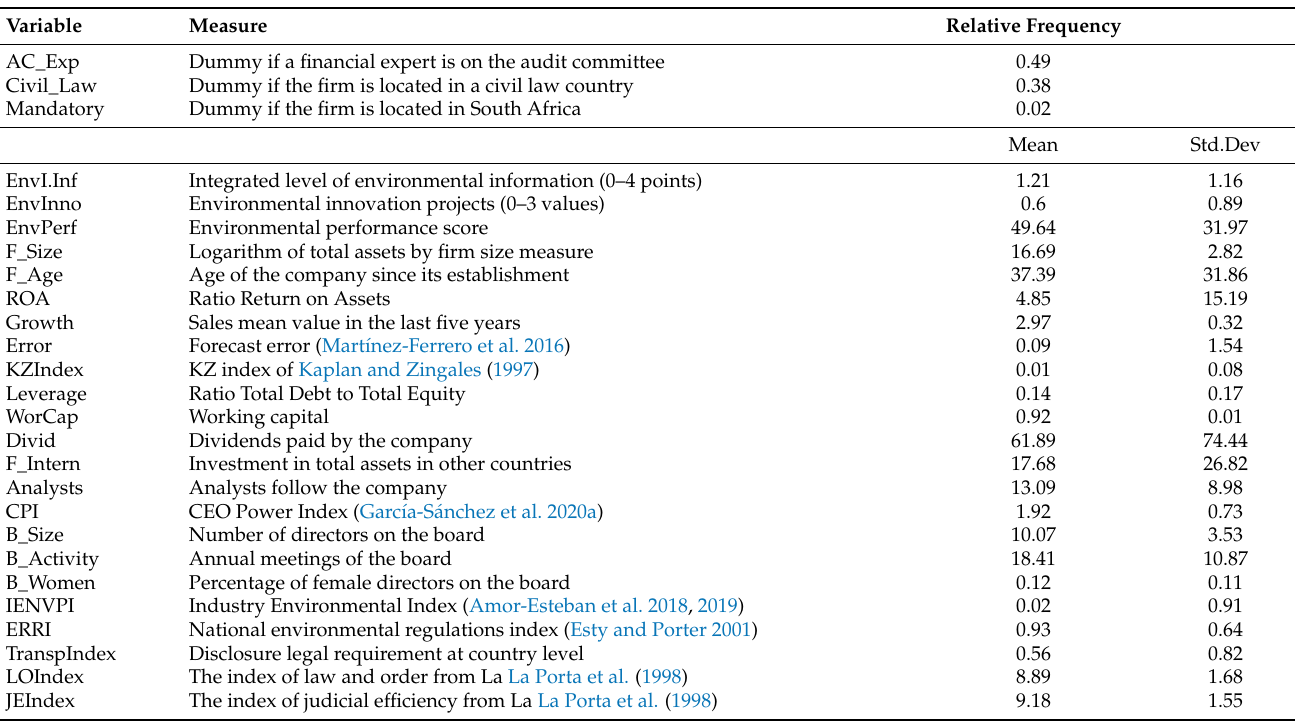
Table 2. Variables and descriptive